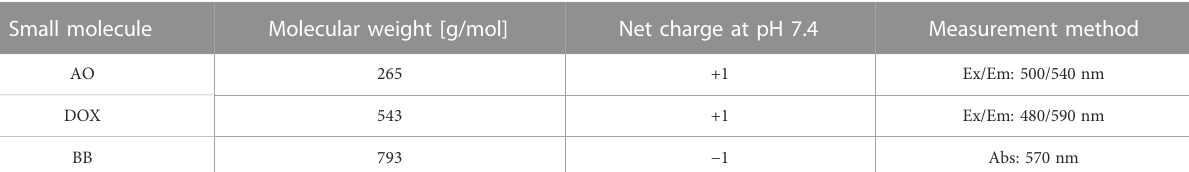
TABLE 1 Properties of small molecules used for bulkrelease studies. molecular weight, net charge, and excitation/emission wavelengths for acridine orange (AO), doxorubicin(DOX),andBrilliantBlue FCF(BB).Ex/Emreferstoexcitationandemissionwavelengthsof fl uorescencemeasurements,whileAbsreferstoabsorption measurement at indicated wavelength.